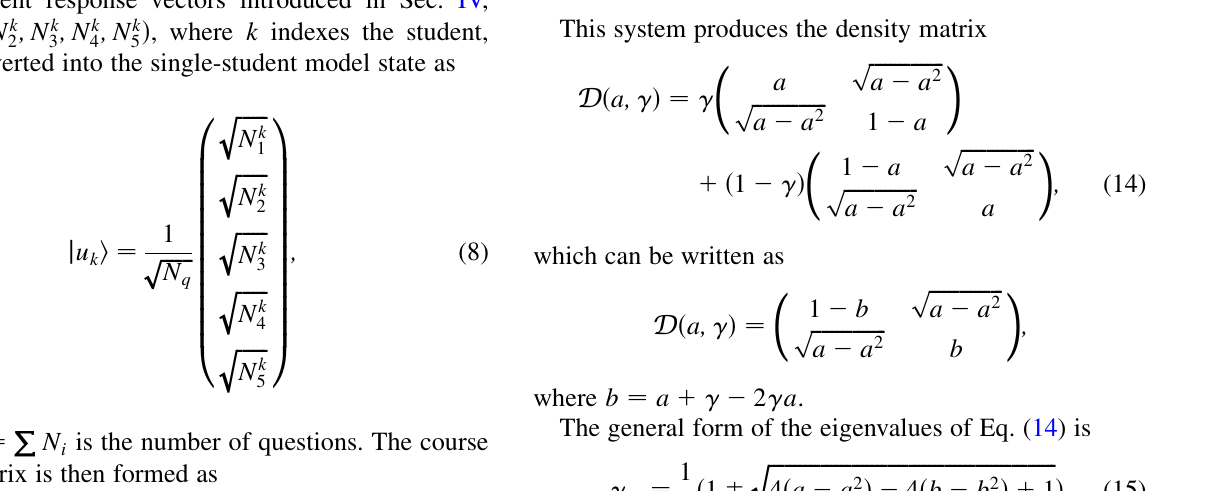
ffiffiffiffiffiffiffiffiffiffiffiffiffiffiffi p a (cid:1) a 2